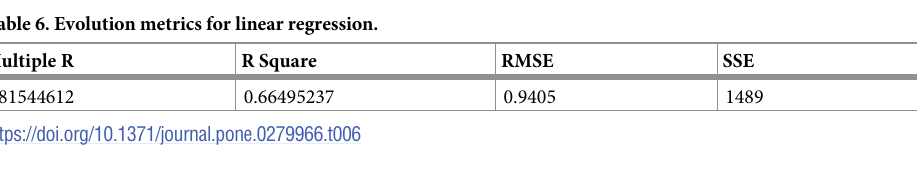
PLOS ONE | https://doi.org/10.1371/journal.pone.0279966 January 6,